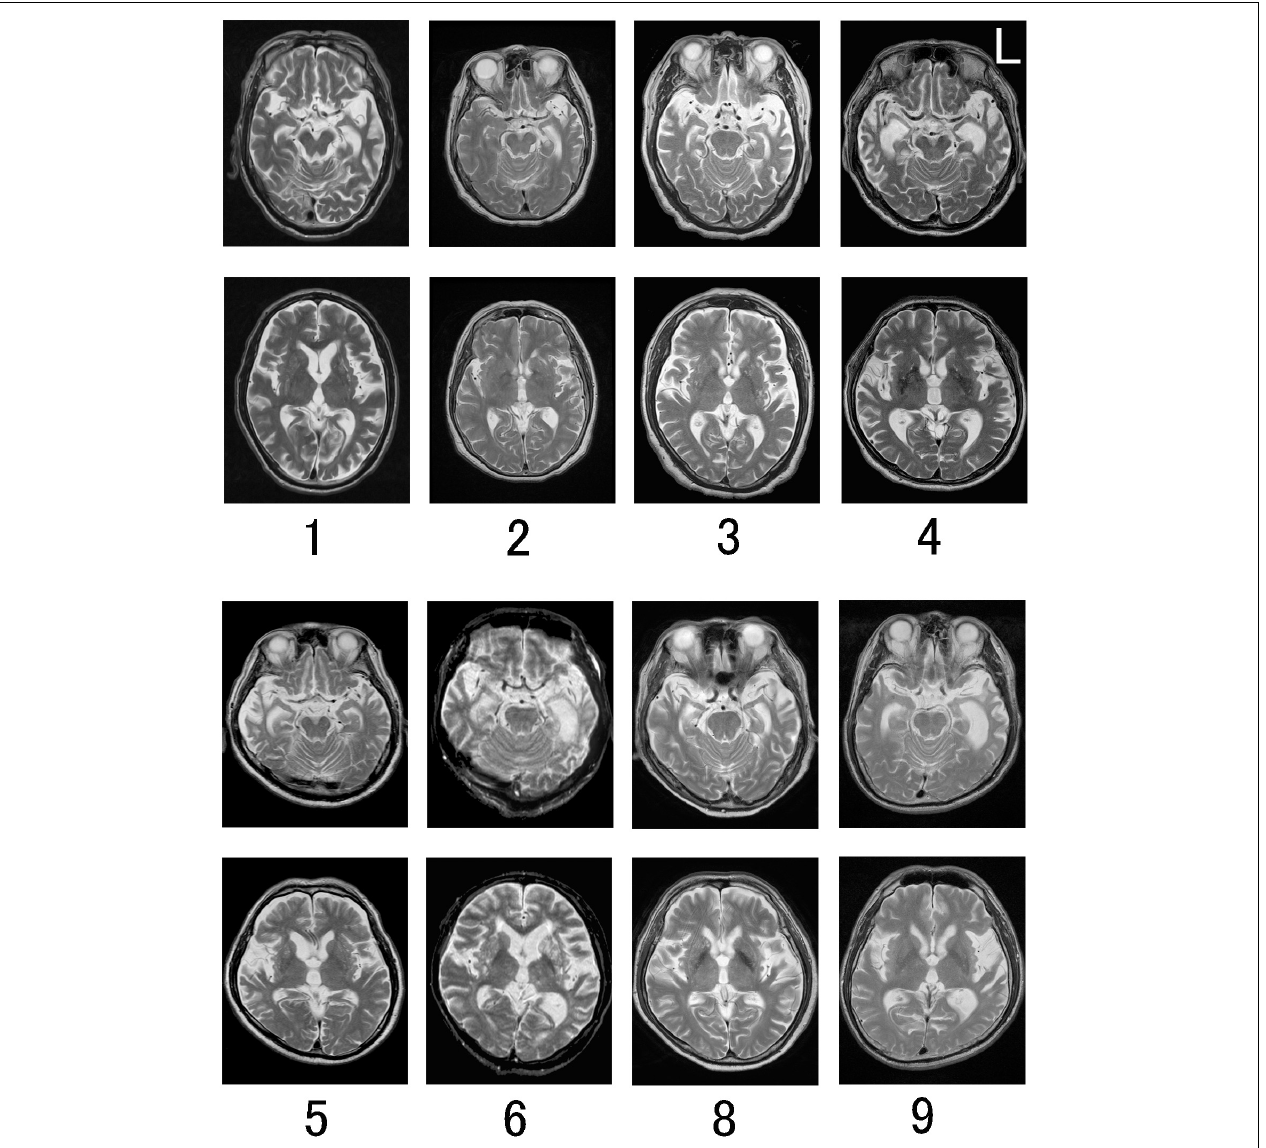
FIGURE 5 | MRI T2-weighted images of eight semantic dementia patients. Number corresponds to the patient number in Table 1 . MRI of patient 7 is not shown. Temporal lobe atrophy was left-sided only (Patients 1 and 2), left-right nearly equal (Patients 3, 4, and 8), right-predominant (Patient 5), and left-predominant (Patients 6 and